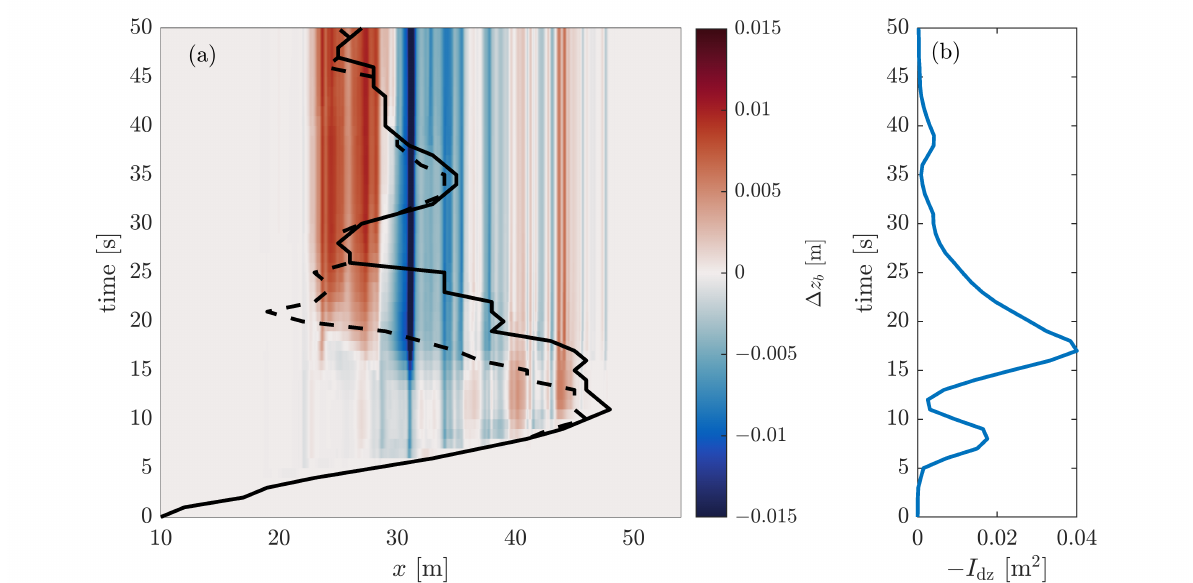
Figure 11. Figure showing the morphological change and runup ( a ) and integrated bed level change ( b ) over time, as predicted by the model. The black lines show the runup, defined as the maximum position where a certain increase in surface elevation compared with the initial condition is recorded (elevation of 1 cm for the straight line and 2 cm for the dashed line).